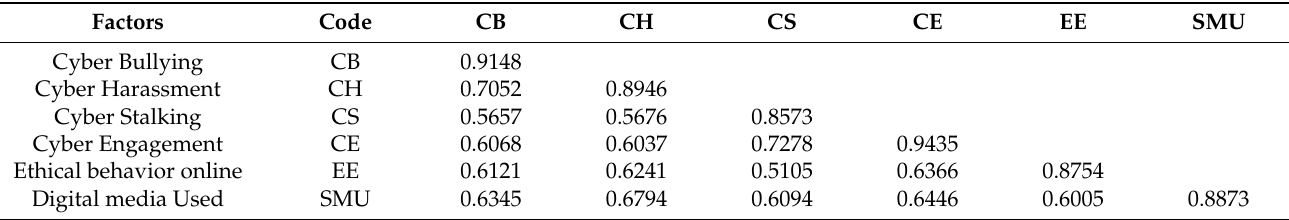
Table 3. Discriminant validity and